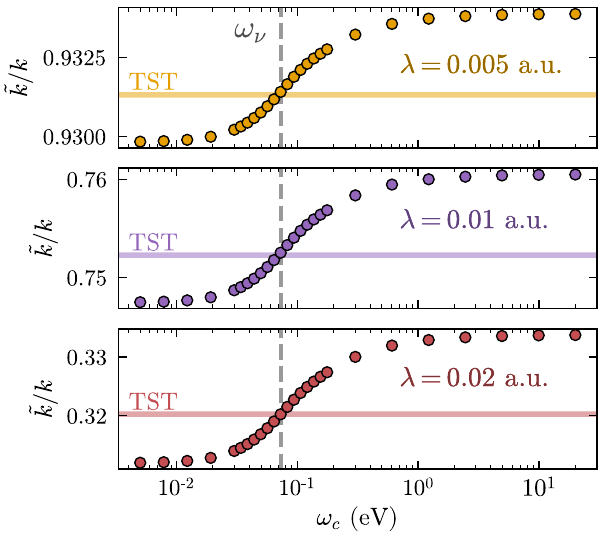
˜ k ) and off-cavity ( k ) rates vs the FIG. 7. Ratio between on- ( cavity frequency for three different values of the coupling strength. We increase the density of points close to the vibrational frequency of the molecule ω ν ≈ 72 . 6 meV in order to explore potential resonance